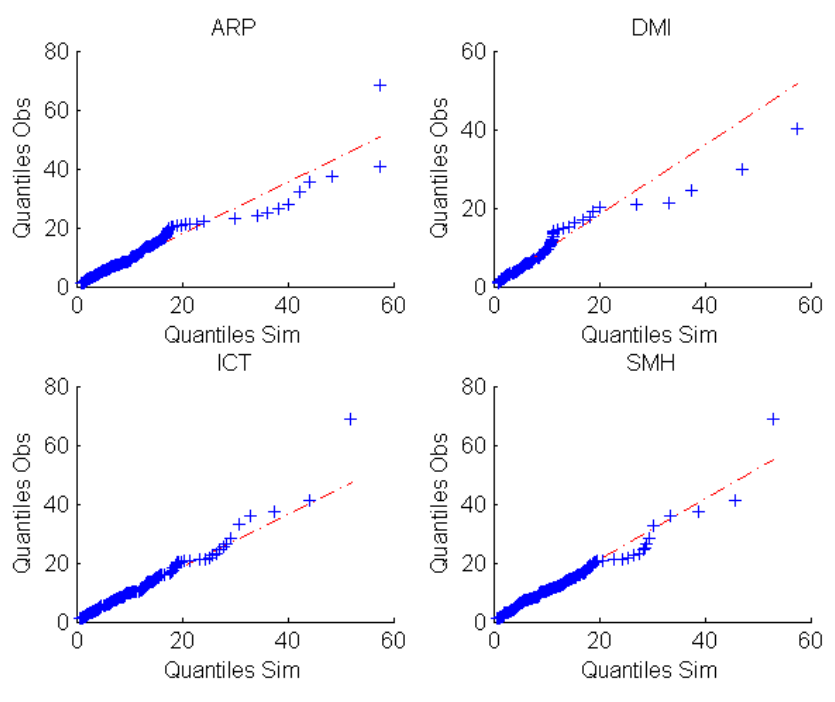
Figure 6. Scatter plot of precipitation quantiles of bias corrected series including dry day correction and quantiles of observed series for the validation period and MAM spring